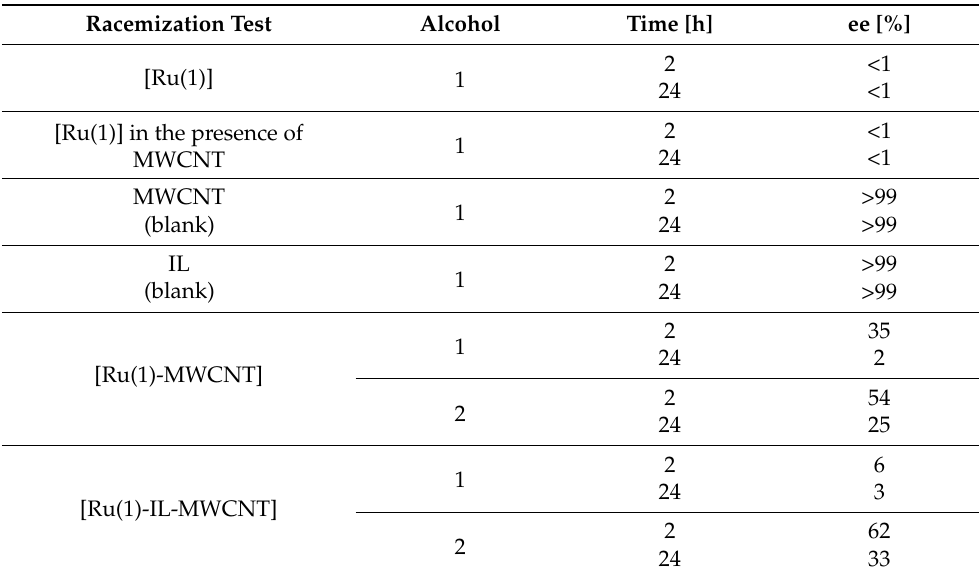
Table 1. Results of racemization tests for the obtained heterogeneous catalysts. Racemization Test